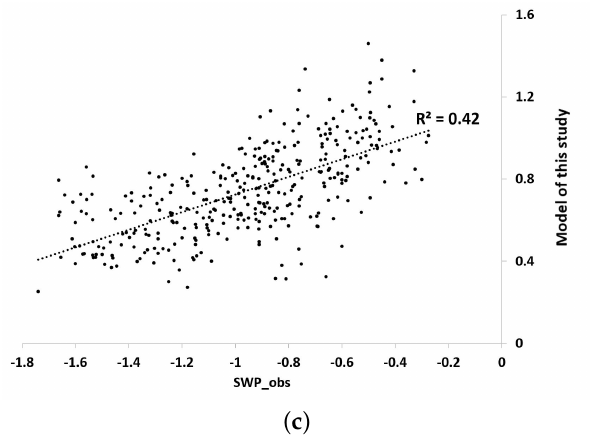
Figure 15. Distribution of the observed SWP according to ( a ) NDVI values, ( b ) REP values, ( c ) values of the model developed in this